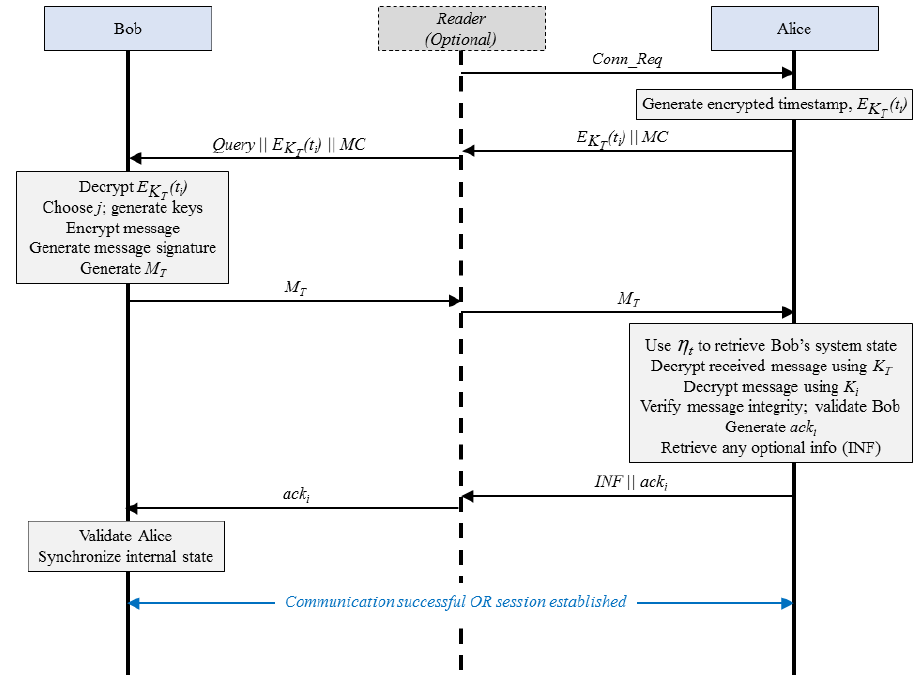
Figure 2. Protocol of Operation (Generalized Version of the Protocol Presented in [8]). Table 1. Message Code ( MC ) format and description